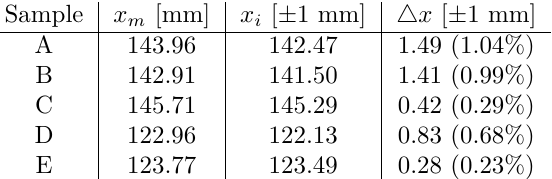
Table 2. Listed values of displacement based on image data ( x i ) and based on machine data ( x m ) at the time when first breakage of the specimen occurred. Difference of displacement between machine data and image data ( 4 x ) is presented in the last